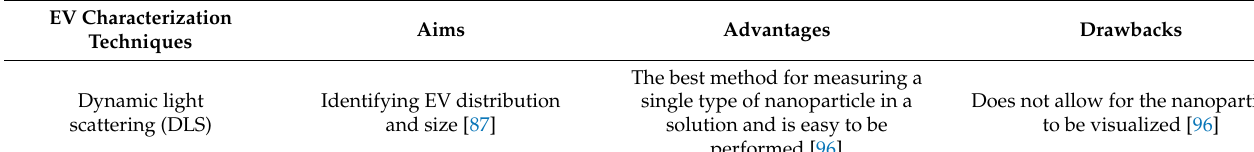
Table 2. EV characterization techniques’ advantages and